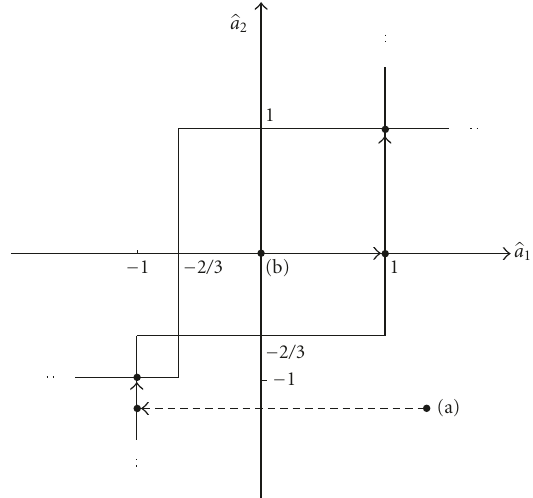
Figure 1: Analysis of a locked error situation with convergence chart formed by two nested hard decision functions for BPSK and IHDIC with serial update : initialization (a) converges to the wrong solution ( − 1, − 1), whereas for initialization (b) the correct solution (1,1) is found. Therefore, solution ( − 1, − 1) corresponds to a locked error